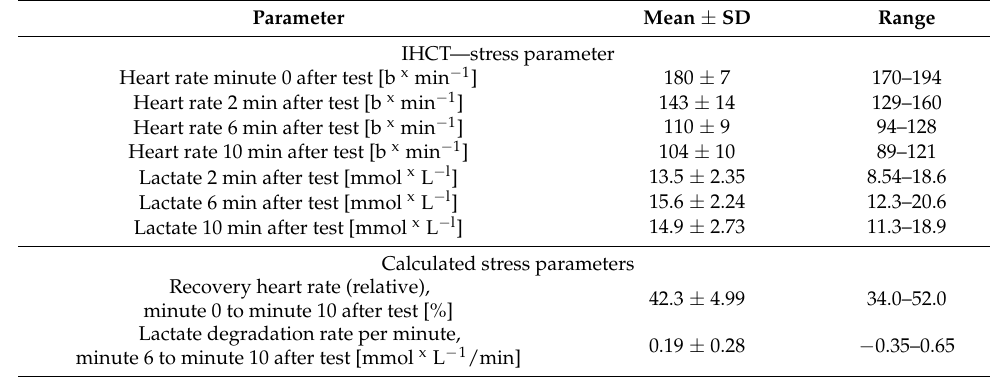
Table 2. Descriptive data for all IHCT parameters and the match performance score